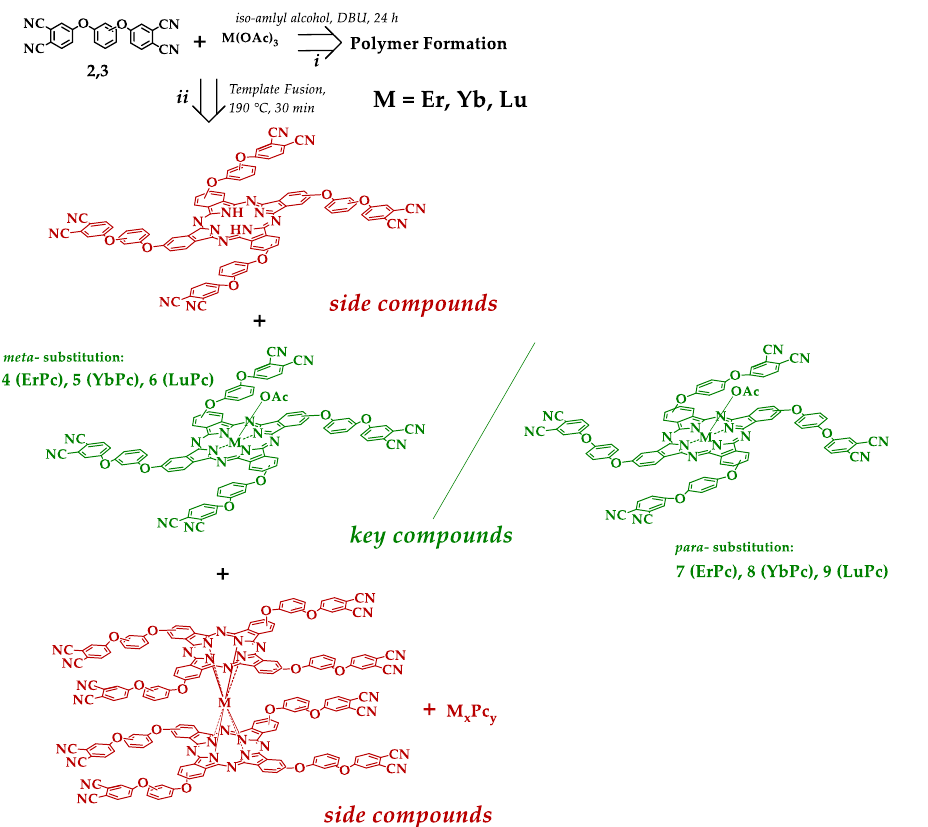
Scheme 1. Strategy for obtaining complexes of rare-earth elements with [3/4-(3,4-dicyanophe- noxy)phenoxy]-phthalocyanine ligands (( i ): Reflux in iso -amyl alcohol, DBU, 24 h; ( ii ):